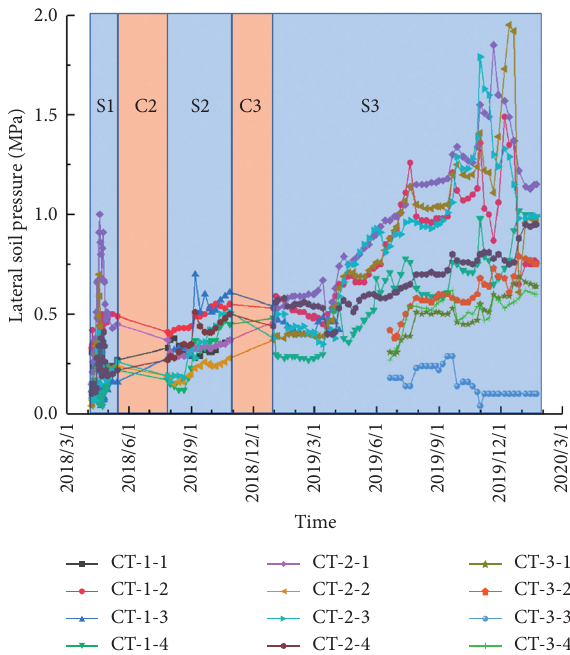
Figure 11: The change of the lateral soil pressure during caisson excavation.